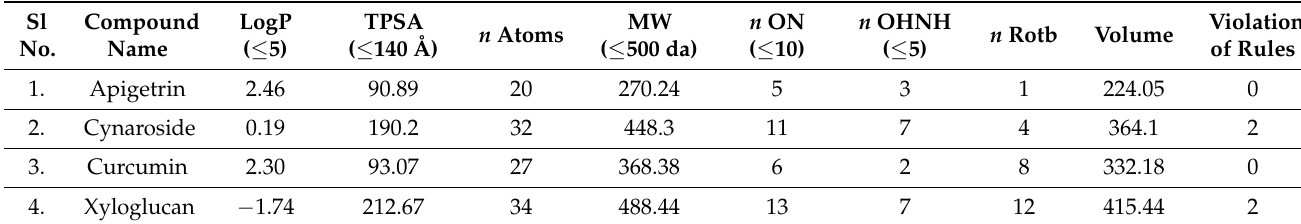
Table 1. Drug likeness score of compounds.